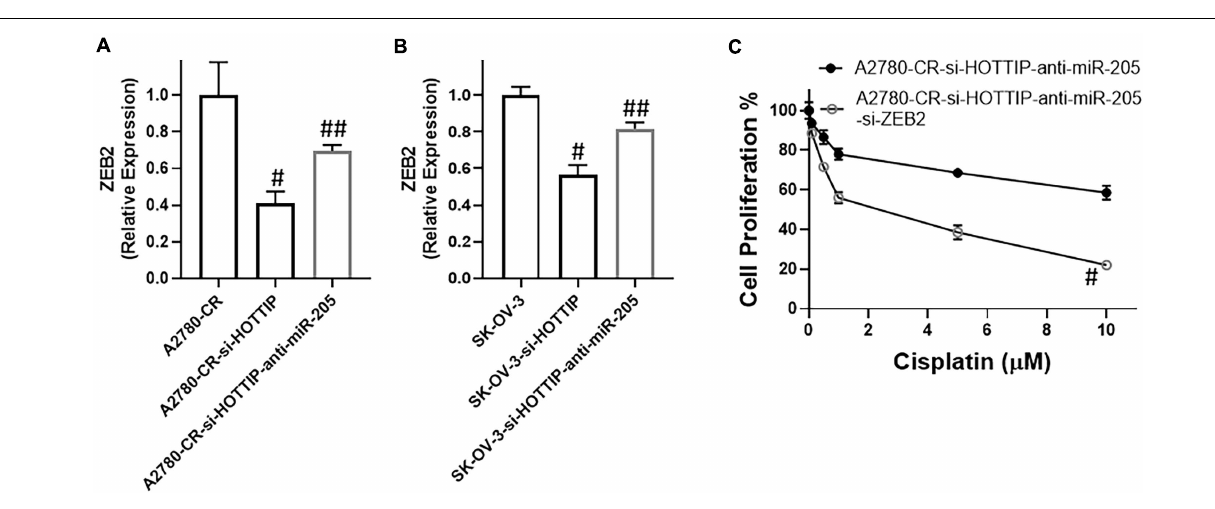
FIGURE 5 | Expression of ZEB2, in (A) cisplatin resistant A2780 and (B) SK-OV-3 cells under specified conditions (HOTTIP silencing with without anti-miR-205) was measured, using RT-PCR. (C) Cell proliferation under specified conditions (HOTTIP silenced A2780-CR cells with anti-miR-205 and additionally with and